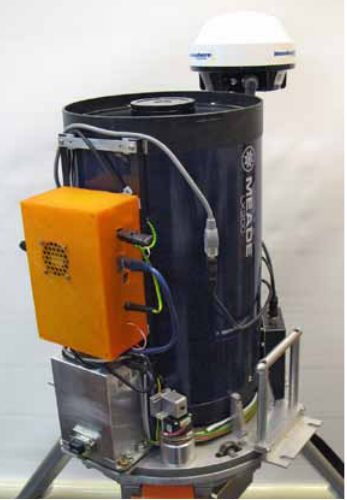
Fig. 1. Zenith camera. All measuring devices and actuators are on the rotating upper